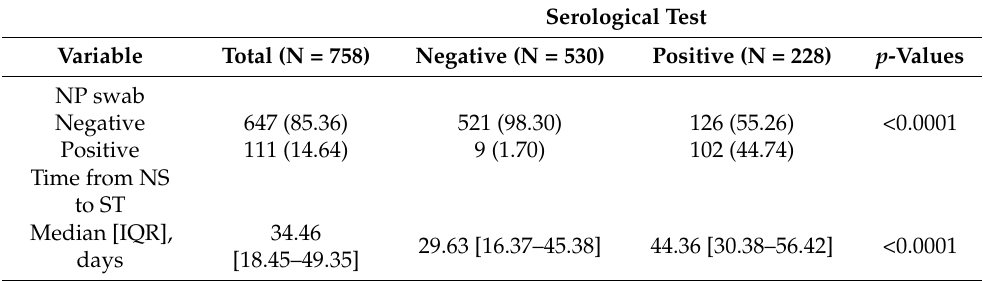
Table 2. Results of healthcare workers (HCWs) with previous nasopharyngeal swabs (N = 758). p -values were obtained using chi squared/Fisher’s test or Student’s t -test/non parametric test, as